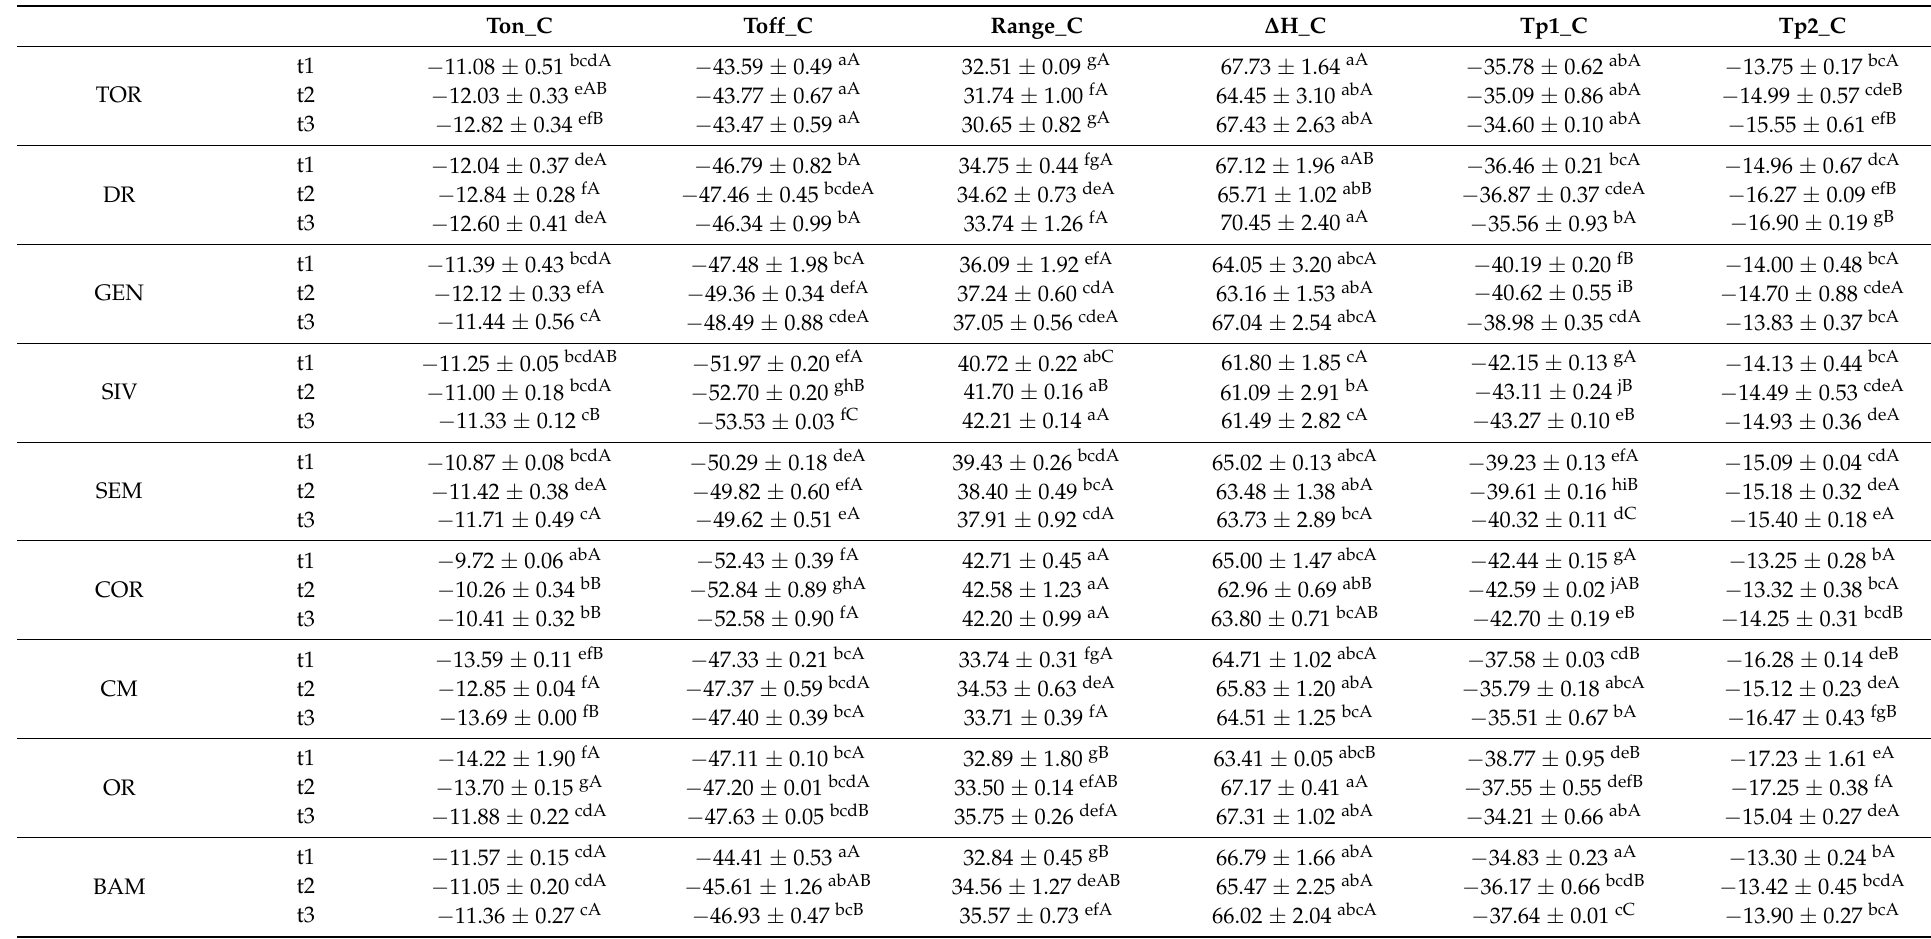
Table 3. DSC cooling parameters of 13 Italian minor olive oils from harvested at three different maturation stages 1